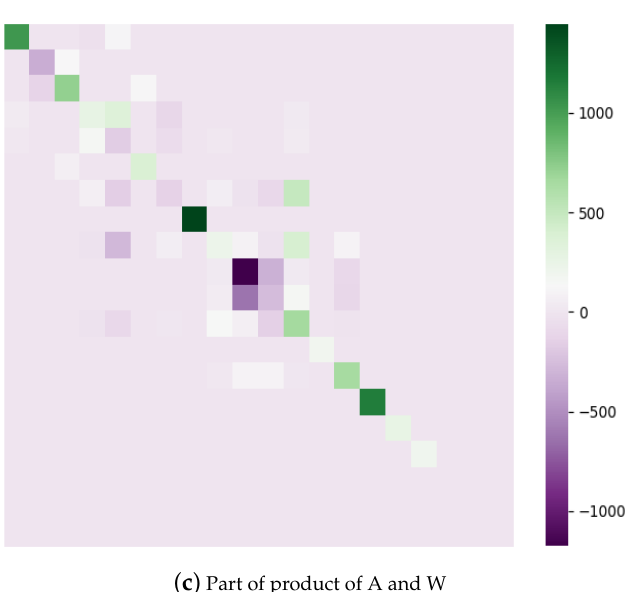
Figure 11. The HGCNInf weight